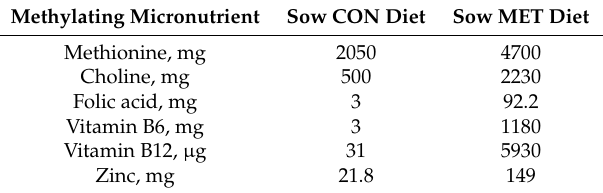
Table 1. Dietary amount of altered micronutrients fed to gilts during gestation (per kg diet). Methylating